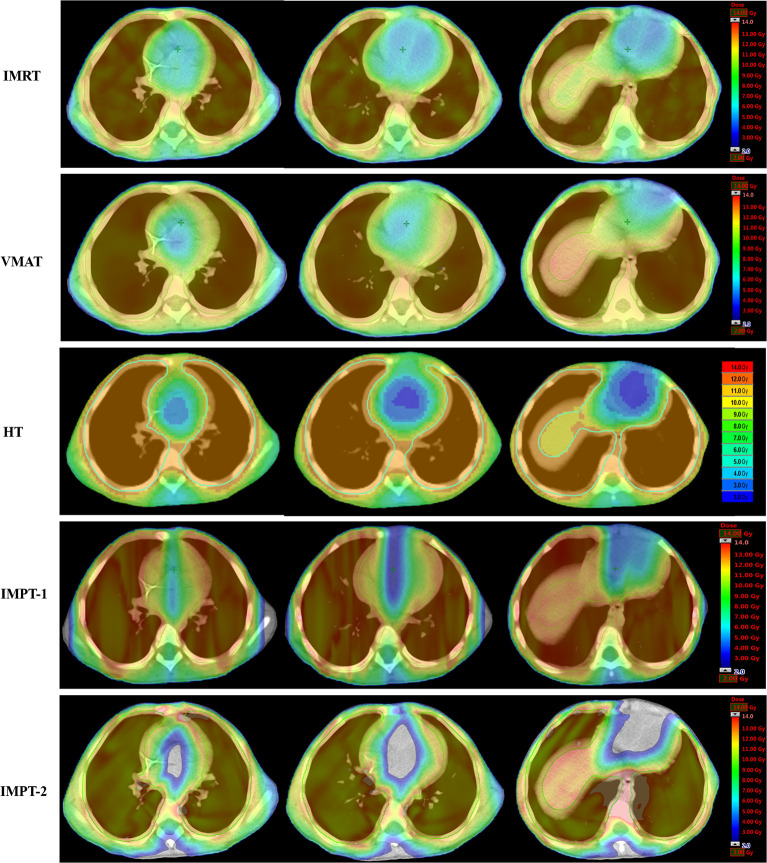
Color wash of the absorbed-dose distribution (transverse plane) to the heart in four-year-old male patients.